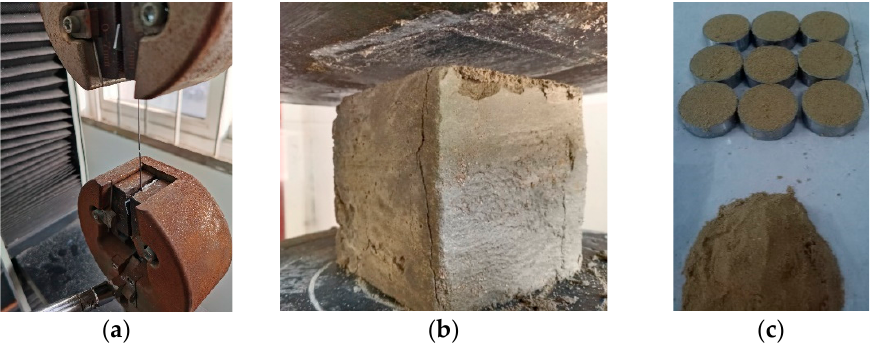
Figure 13. Proportioning tests: ( a ) breaking force test, ( b ) compressive strength test, and ( c ) direct shear test. Figure 14. Model making: ( a ) model soil, ( b ) grid steel frame model, and ( c ) primary support.